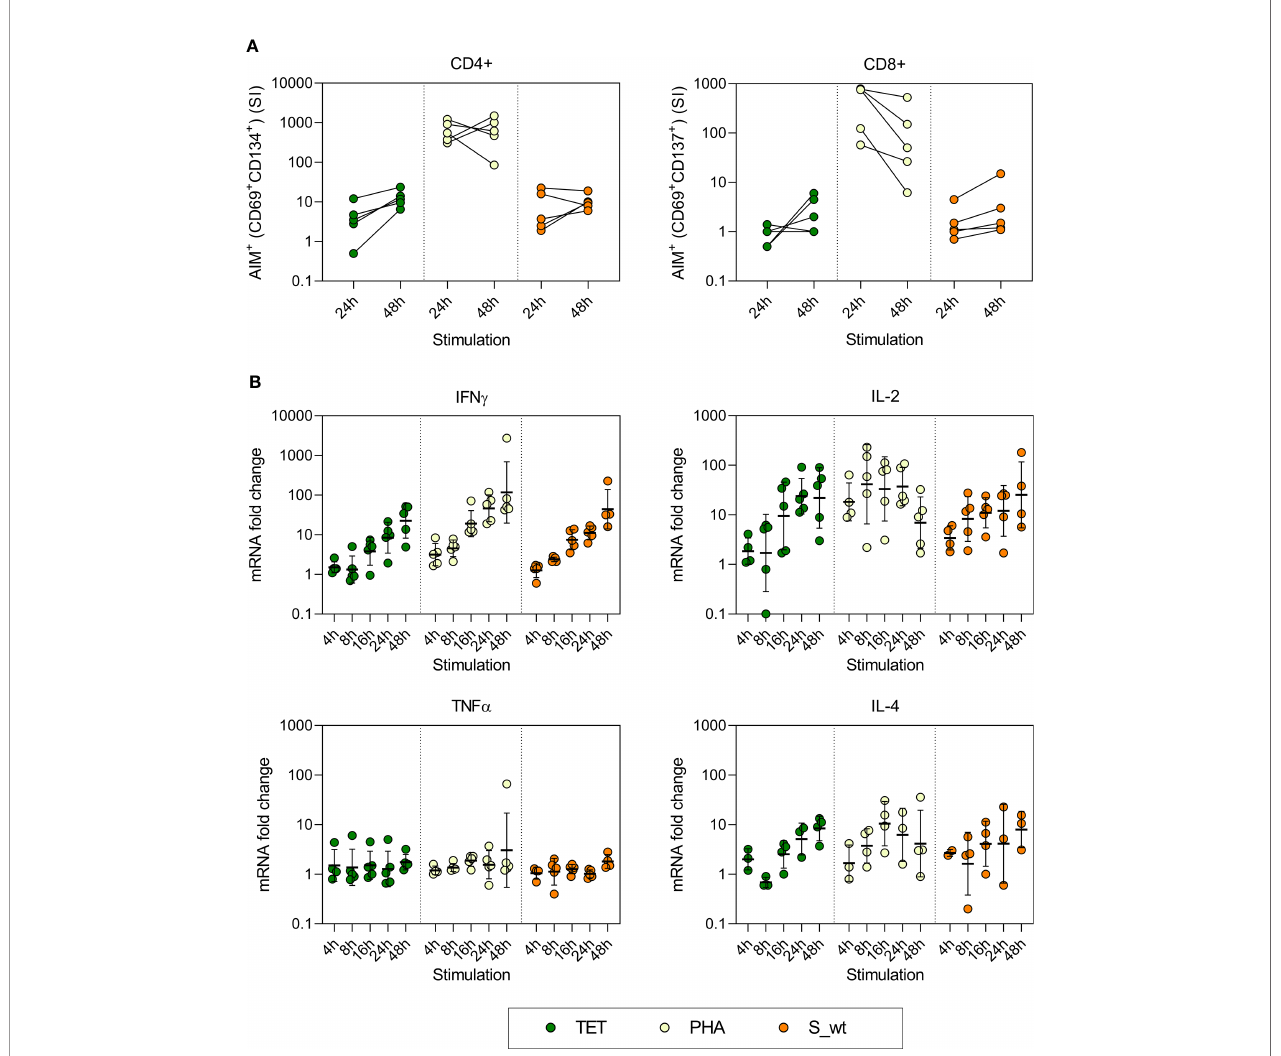
FIGURE 1 | Optimization of AIM test and the kinetics of cytokine mRNA expression of stimulated PBMCs. PBMCs collected from fi ve vaccinees were stimulated with 10 µg/ml pf tetanus toxoid (TET), 1 µg/ml PHA, and 0.5 µg/ml SARS-CoV-2 Wuhan Hu virus spike peptide pool (S_wt) for 4, 8, 16, 24, and 48h. (A) After 24h and 48h stimulation, speci fi c T cell responses were measured with fl ow cytometry using expression of CD69 and CD134 as a marker for CD4 + T cell activation, and CD69 and CD137 as a marker for CD8 + T cell activation. Stimulation index (SI) was calculated by dividing the percentage of AIM + cells after TET, PHA, or S_wt stimulation with the percentage of AIM + cells after DMSO stimulation. (B) Cytokine mRNA expression was analyzed with RT-qPCR from total cellular RNA isolated from cells collected at different times after stimulation. RNA levels at different time points were compared to corresponding DMSO treated samples. The geometric means and standard deviations are show in the fi